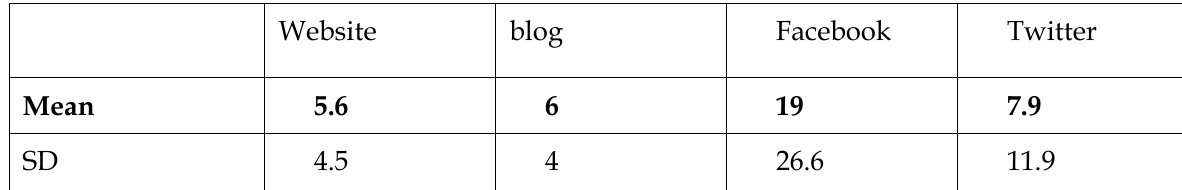
Table 3: number of posts on websites, blogs, Facebook and Twitter, in one week, February 2016 (source: au- thor)